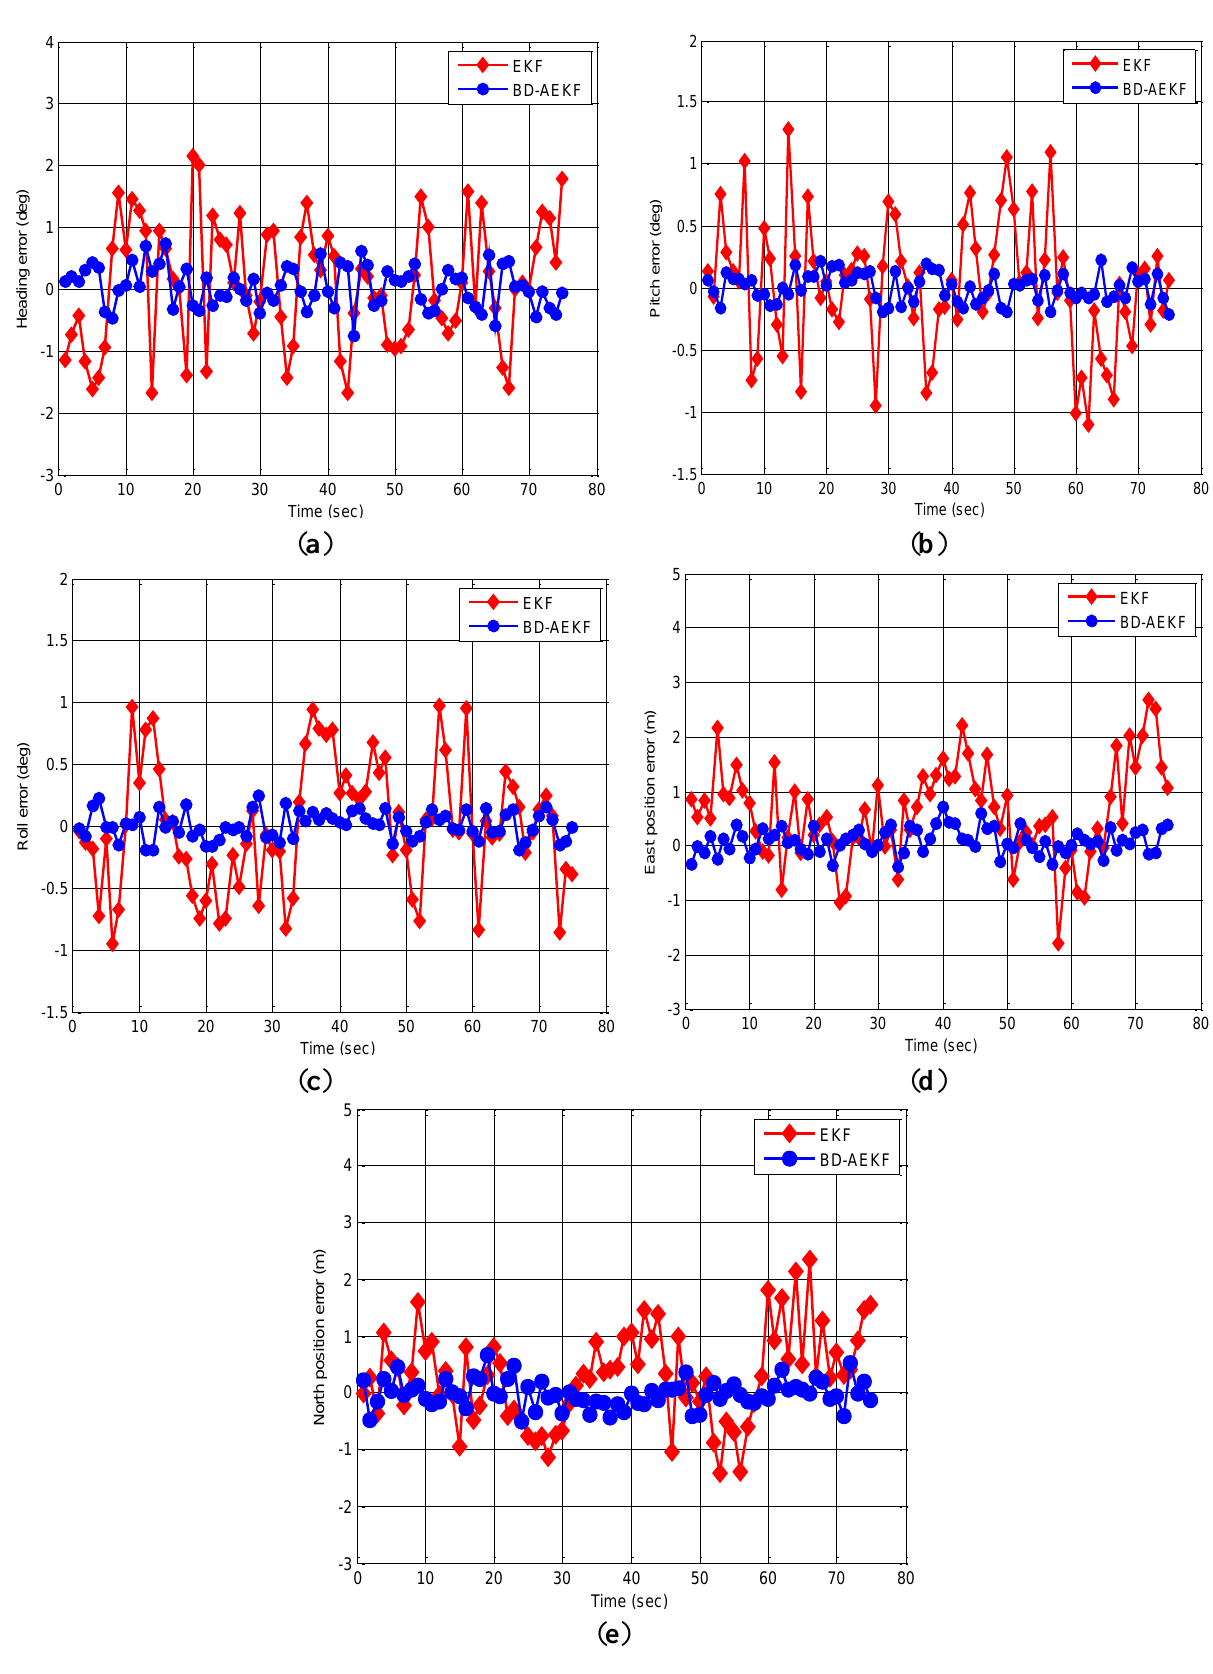
Figure 6. The errors for EKF and BD-AEKF in the line trajectory. ( a ) Heading ( b ) Pitch ( c ) Roll ( d ) East position ( e ) North